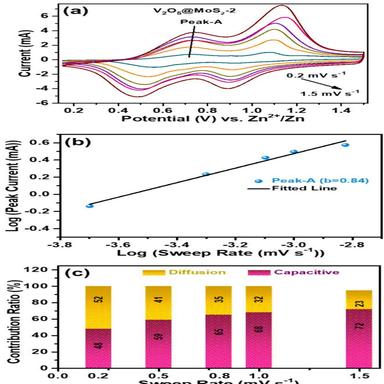
(a) CV curves at various sweep rates, (b) relationship between log (peak current) versus log (sweep rate), and (c) capacitive contribution ratios at various sweep rates for the V2O5@MoS2–2 NCs cathode.